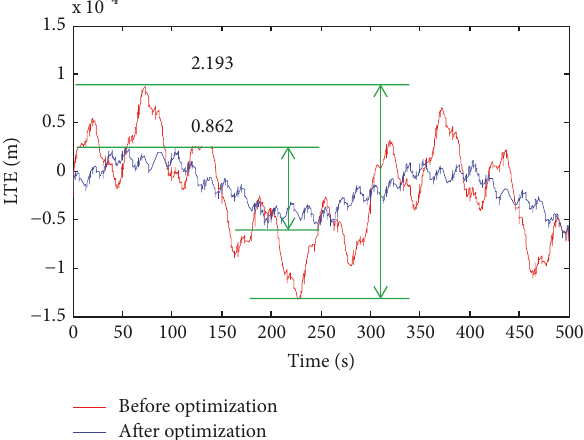
Figure 16: Time-domain comparison of LTE prior to and following optimization.